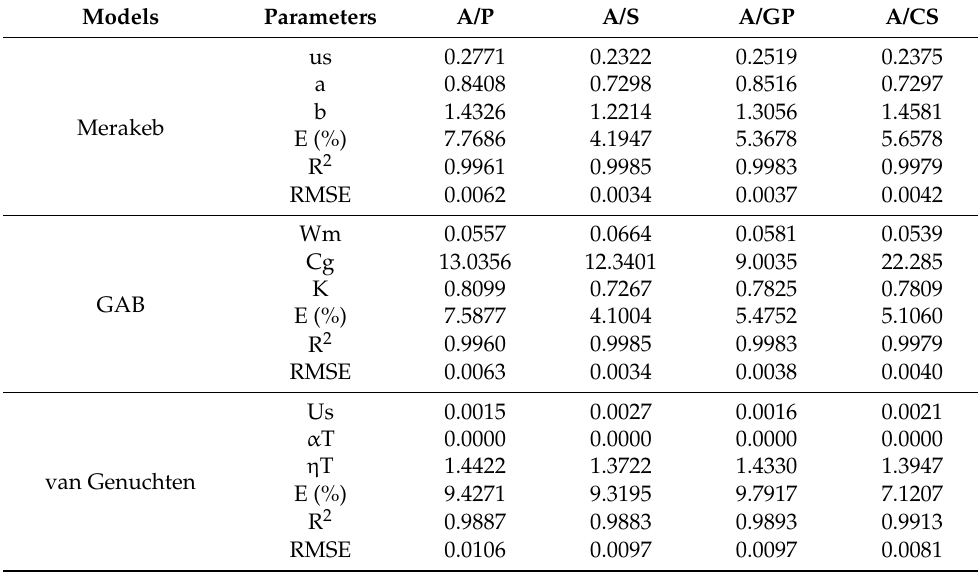
Figure 5. Sorption isotherms of the four composites and comparison of experimental data with Merakeb, GAB, and van Genuchten models: ( a ) A/P, ( b ) A/S, ( c ) A/GP, and ( d ) A/CS. Table 3. Parameter values for sorption isotherm